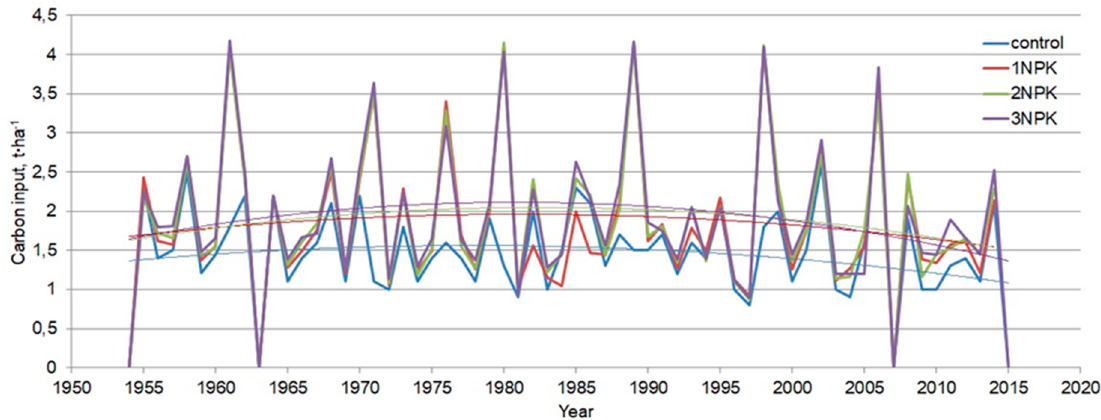
Figure 3. The annual C input in the long-term field experience of VNIISS in total, taking into account the application of organic fertilizers. On the axis of abscissas—the input of organic C, t · ha − 1 with crop biomass, as shown in Figure 2 and calculated based on the composition of FYM, on the axis of ordinate—the year of input. Smoothing was performed using second-degree polynomials.